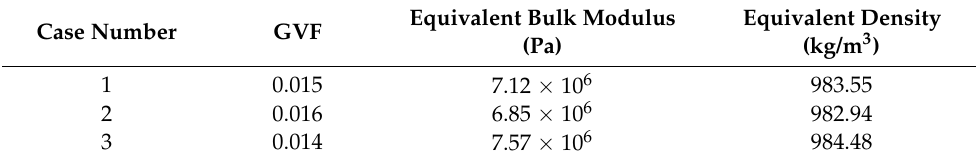
Table 3. Equivalent fluid properties.